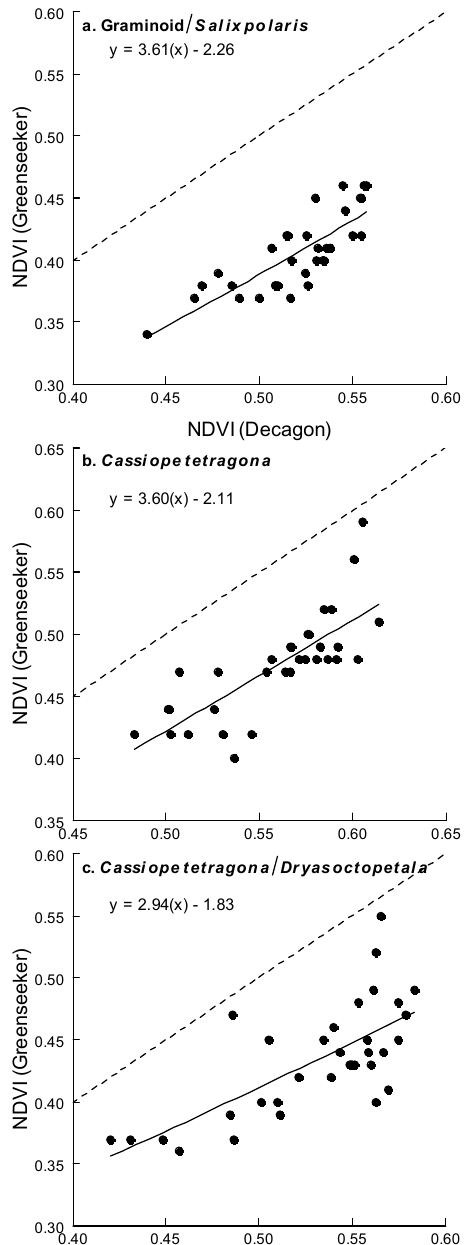
Figure 4. Comparison of Decagon surface reflectance sensor-derived NDVI (passive) and Trimble